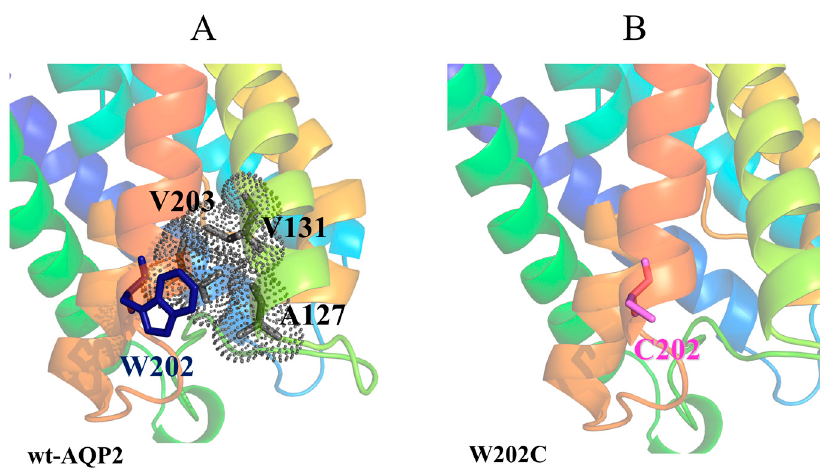
Figure 5. Structural representation of W202C mutant. Cartoon representation of: ( A ) human AQP2 wild type and ( B ) W202C mutant with native and mutated residues shown as blue and violet sticks, respectively. The residues interacting with W202 in AQP2 wild type are shown as gray sticks with dot surface, whilst in W202C mutant no interactions involving C202 are found. The discussed residues are labeled.